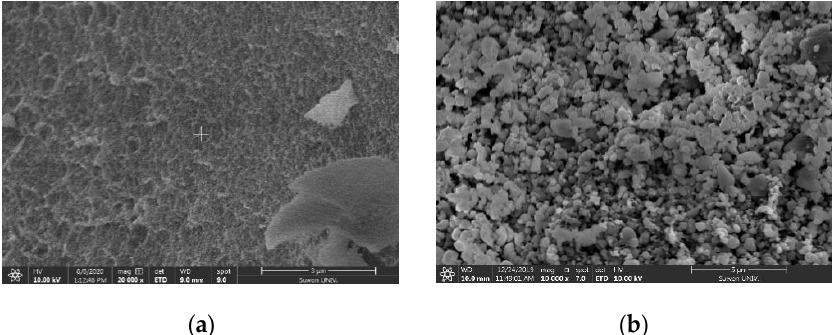
Figure 14. Scanning electron microscopy images of ( a ) fresh and ( b ) spent 20 wt% Ni-Mg-Al catalysts.